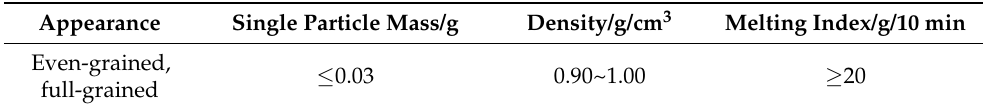
Table 1. Technical index of high viscosity additive.